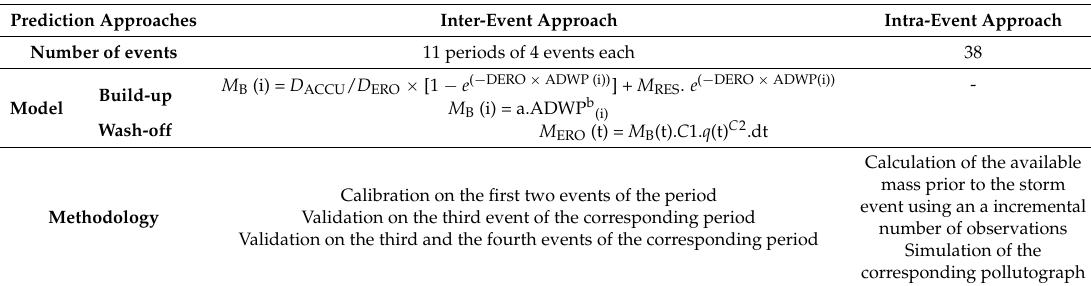
Table 4. Prediction approaches: inter and intra event.